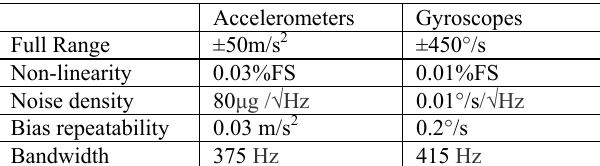
Table 1. Technical parameters of the MTi